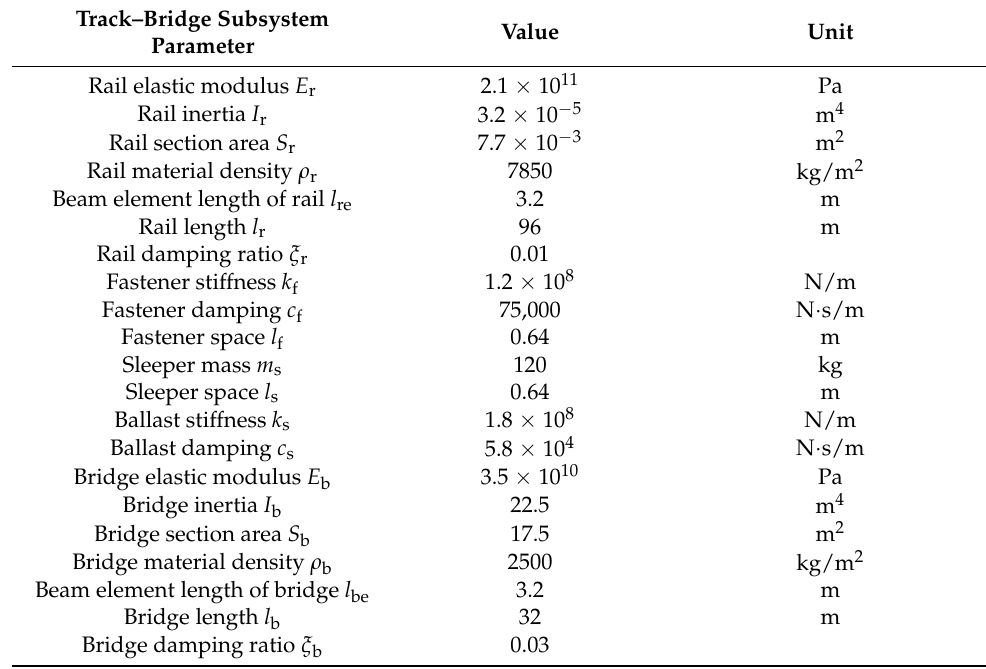
Table 2. Parameter values of track–bridge subsystem [21].